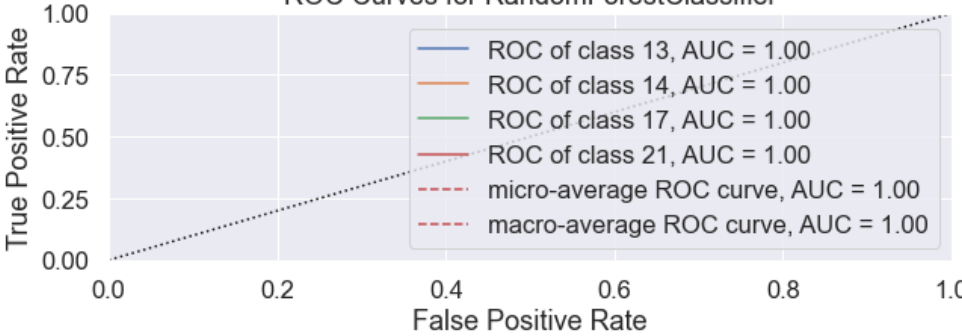
13 of 15 Table 3. Preset and subset selection accuracy of RF. Precision